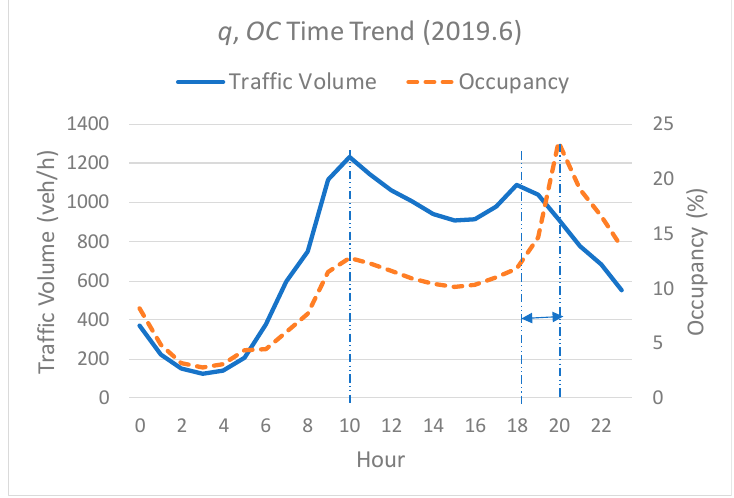
Figure 7. Hourly traffic comparison between traffic volume and occupancy.